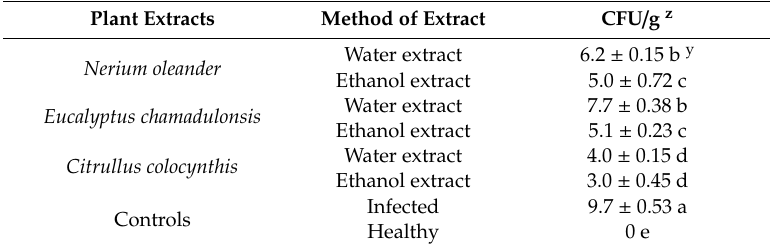
Table 1. E ff ect of 15% concentrations of water and ethanol plant extracts of Nerium oleander , Eucalyptus chamadulonsis and Citrullus colocynthis on the population of Xanthomonas axonopodis pv. vesicatoria PHYXV3 in ‘Super Marmande’ tomato leaves after seven days of